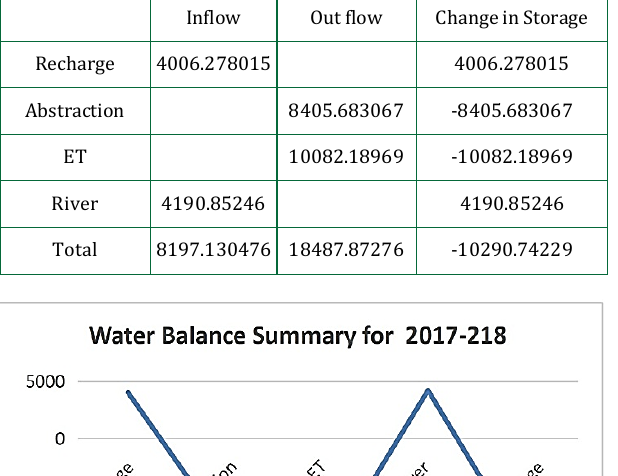
Table 3: Annual Estimation of water Balance in MCM